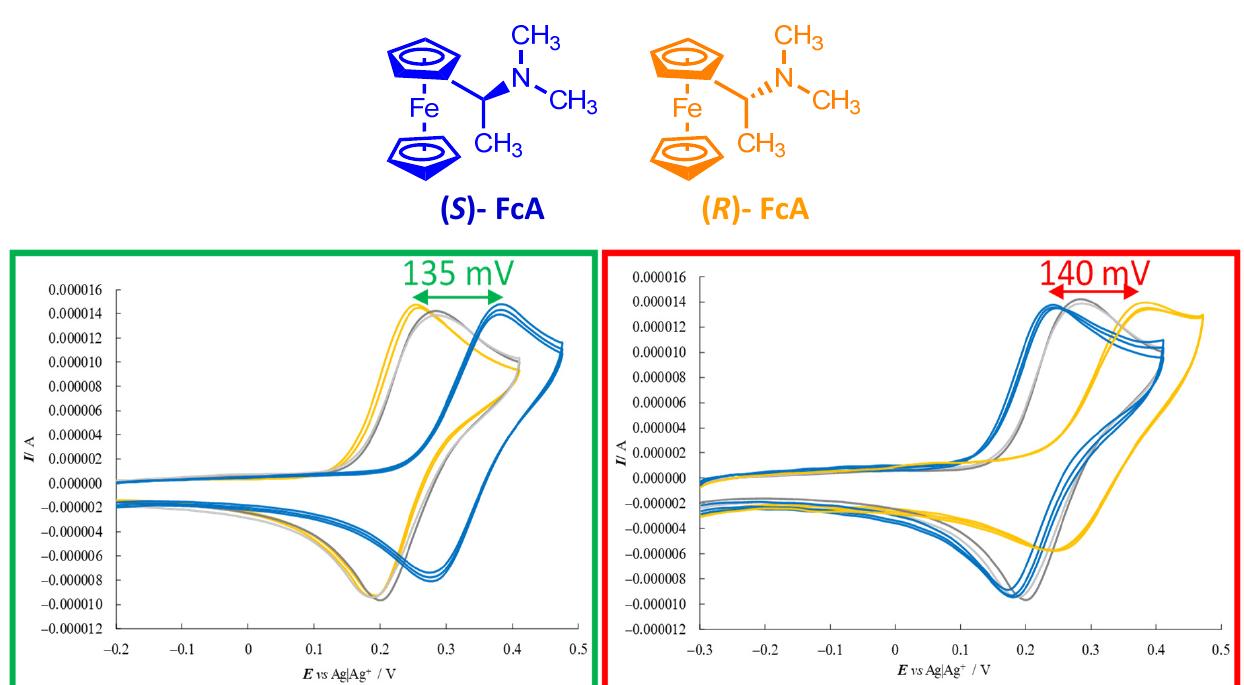
Figure 5. CV patterns of ( S )- or ( R )-ferrocenyl chiral probes (2.0 × 10 − 3 M, blue and yellow, respectively) on screen- printed electrode (SPE) cells with an Au working electrode, in (BMIM)NTf2 with either (P)-5-n-octyl-5-aza[6]helicenium bistriflimidate (1.6 × 10 − 2 M, green frame) or (M)-5-n-octyl-5-aza[6]helicenium bistriflimidate (1.6 × 10 − 2 M, red frame) as additives. Grey voltammograms refer to experiments in absence of azahelicenium salts as chiral inducers.